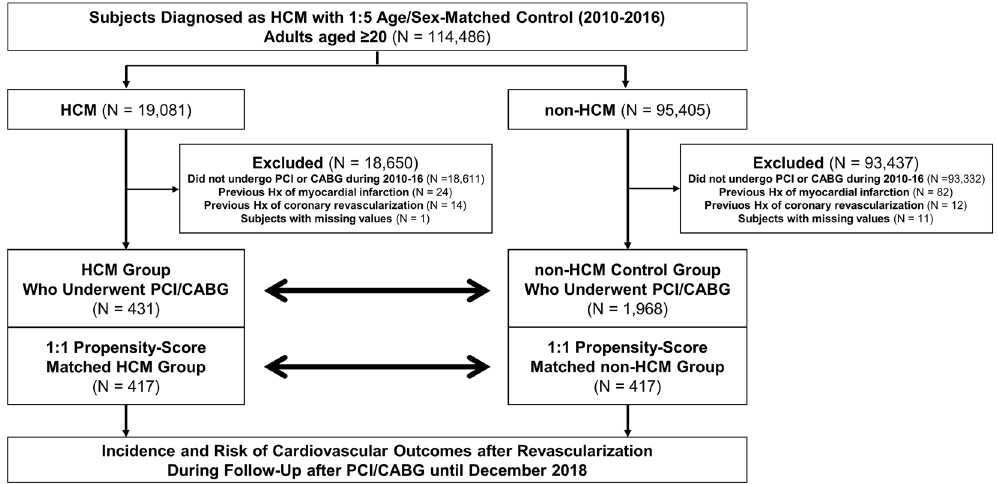
Figure 1. Study flow. From the Korean National Health Information Database, participants aged ≥ 20 were screened and patients with HCM were identified during 2010–2016. Control group without HCM was selected by 1:5 matching of age and sex. The HCM group and non-HCM control group who underwent PCI or CABG during the study period were analyzed. Abbreviations: CABG, coronary artery bypass graft; HCM, hypertrophic cardiomyopathy; Hx, history; PCI, percutaneous coronary